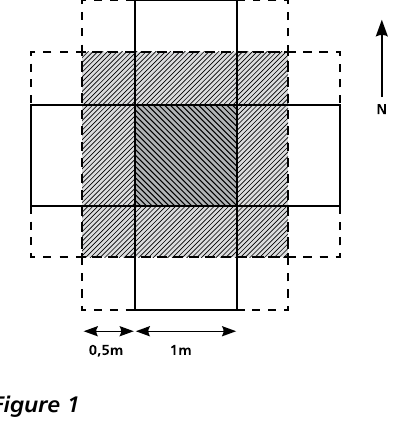
Figure 1 Intersection of the two transects in the middle of the gaps. The 1-m-wide transects are marked with solid lines, whereas the additional 0.5 m-wide sampling units are indicated by dashed lines.